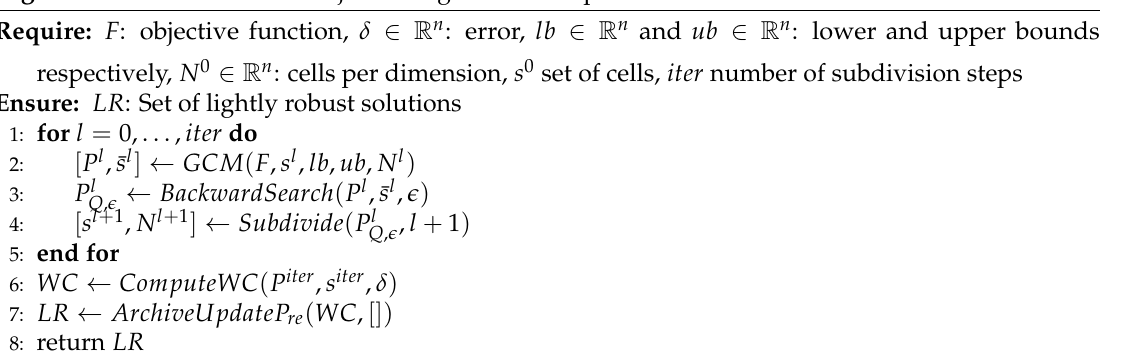
Algorithm 1 GCM for Multi-objective Light Robust Optimal Solutions